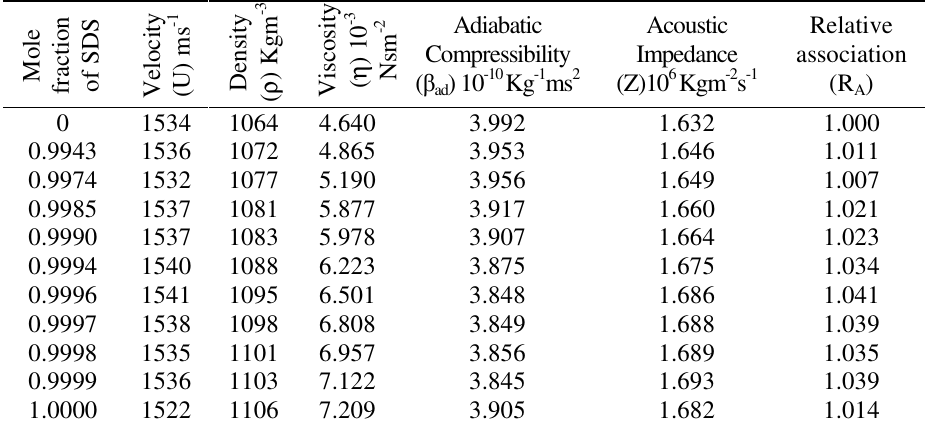
Table 2. Experimental values of surface tension( σ ), free length(L absorption coefficient( α /f 2 ) and internal pressure( п (0.25 N) in poly(vinyl alcohol) solution at 303K. Mole